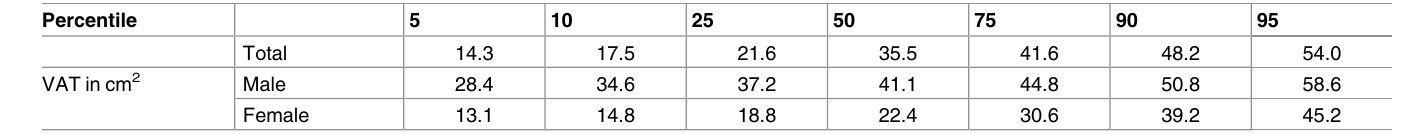
Table 3. Percentiles for